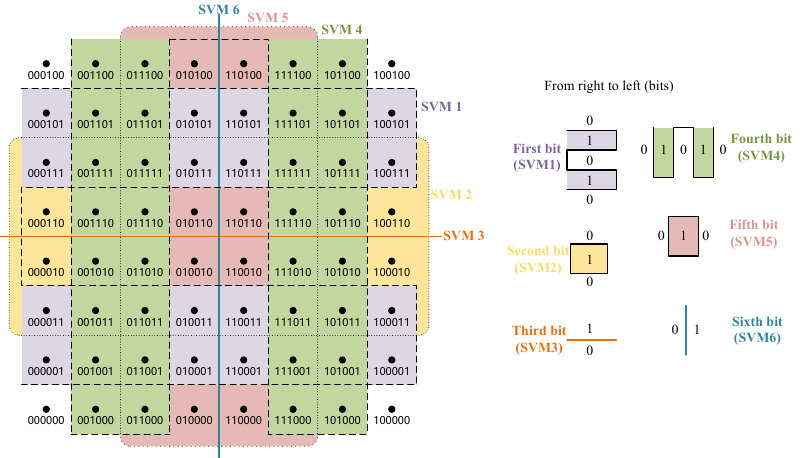
Figure 4. Classification strategy for